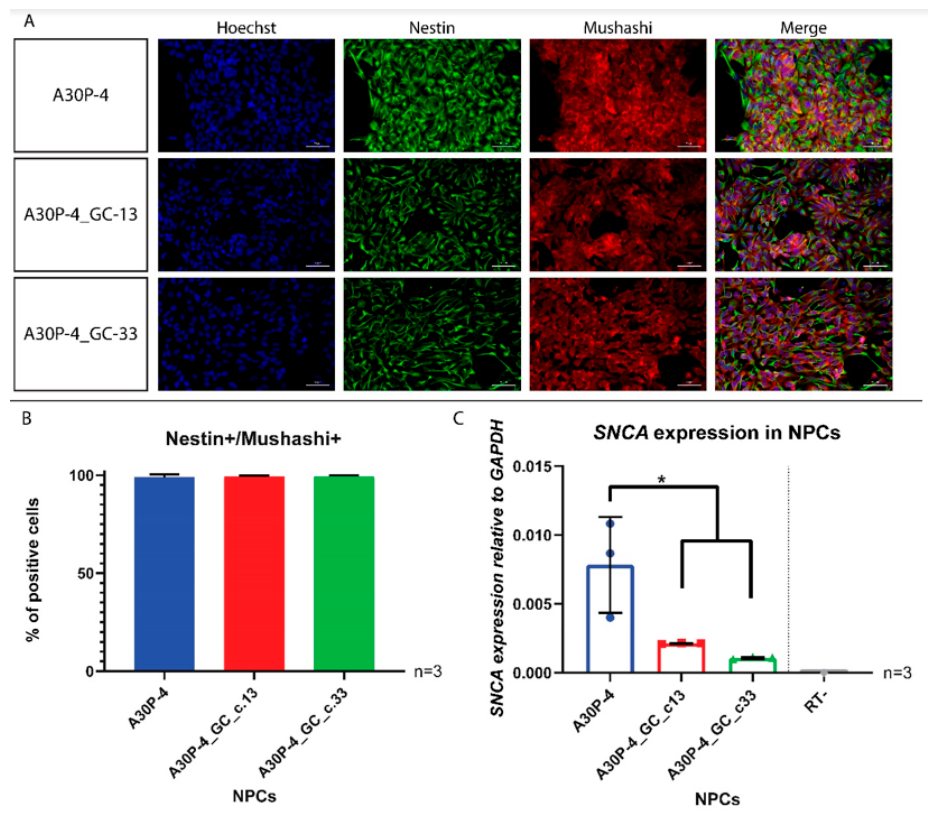
Figure 6. Characterization of neural precursor cells (NPCs) and quantification of SNCA expression. ( A ) Immunofluorescence of NESTIN and MUSHASHI antibody staining. Scale bar is 50 µ M. ( B ) Quantification of NESTIN +/ MUSHASHI + NPCs by flow cytometry ( n = 3). ( C ) Quantitative gene expression of SNCA in NPCs ( n = 3). An ordinary one-way ANOVA was performed using the Tukey post hoc multiple comparison test. * p <